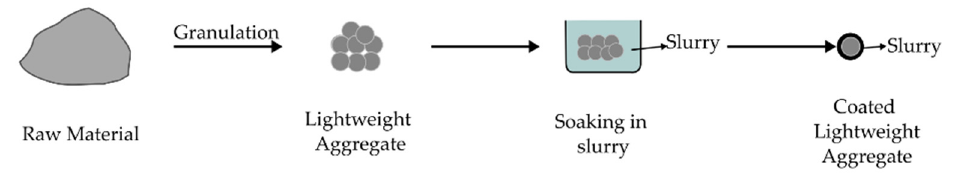
Figure 6. Coating. Figure 6. Coating.